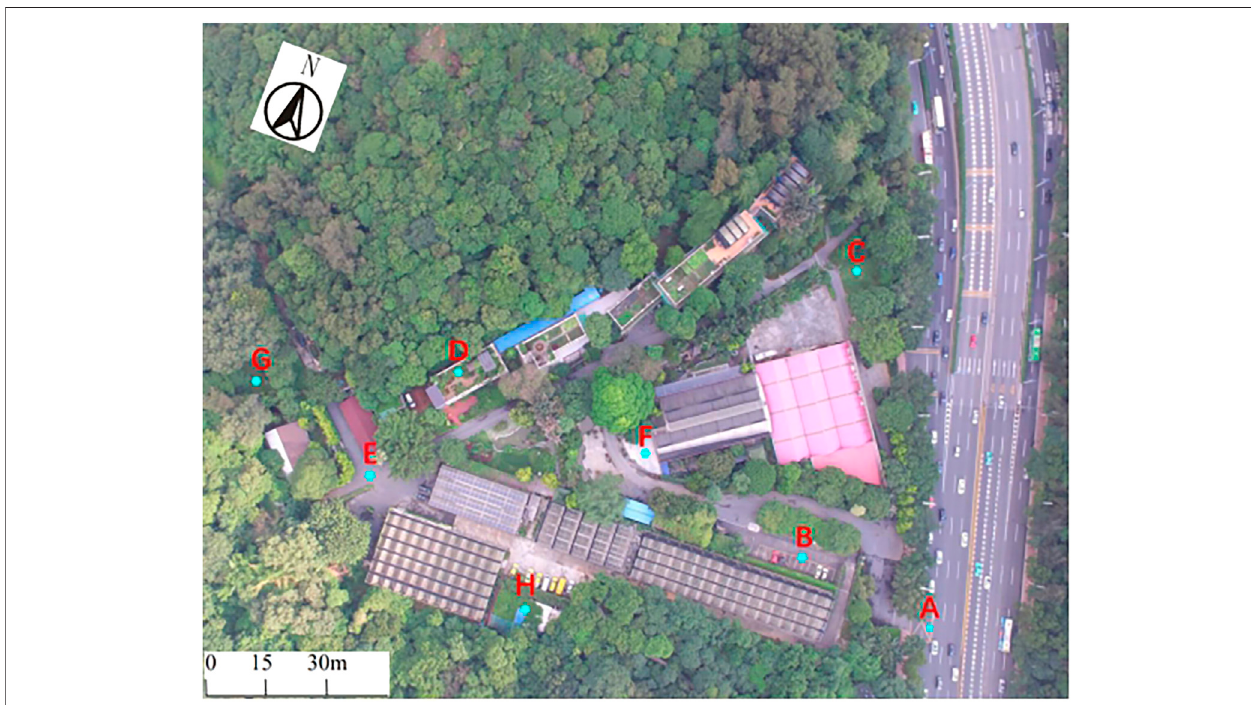
FIGURE1| Samplingsitelocationsforthethreesamplingprograms. (A) Urbanroad, (B) parkinglot, (C) grassland, (D) greenroof, (E) parkway, (F) CK, (G) weather station, (H) Guangzhou urban fi eld station.